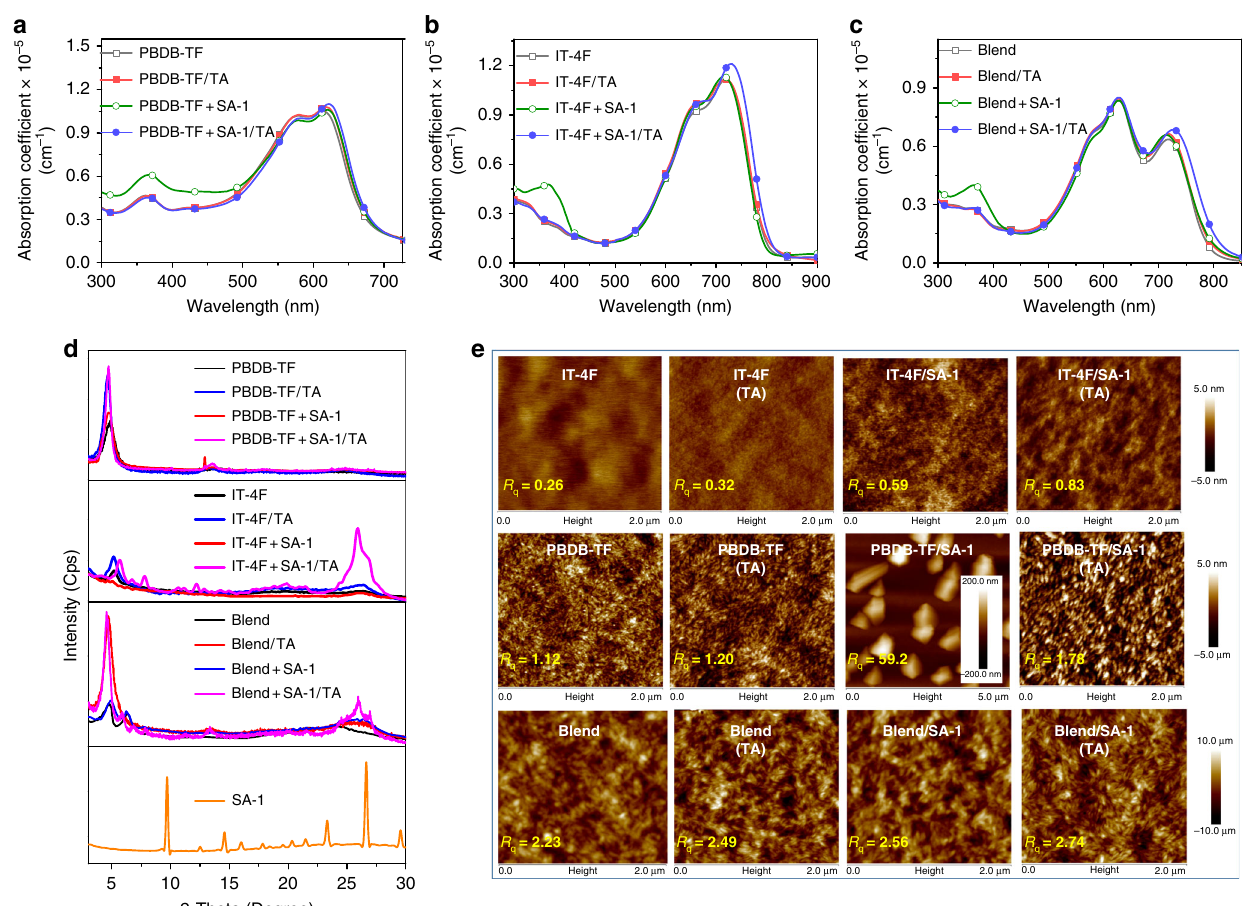
Fig. 3 The in fl uence of SA-1 on the intermolecular interaction and the fi lm morphology. Absorption spectra with absorption coef fi cients of ( a ) PBDB-TF, PBDB-TF/TA, PBDB-TA + SA-1, and PBDB-TF + SA-1/TA fi lms; b IT-4F, IT-4F/TA, IT-4F + SA-1, and IT-4F + SA-1/TA fi lms; c blend, blend/TA, blend + SA-1, and blend + SA-1/TA fi lms. d The corresponding X-ray diffraction patterns and that of SA-1 fi lm without TA. e The corresponding AFM height images (A speci fi ed scale bar is used for the image of PBDB-TF + SA-1 fi fi lm. We fi nd the fi lm thickness dropped approximately 10 nm after treated with TA (Supplementary Fig. 10), suggesting more condensed molecular arrangement in the blend.